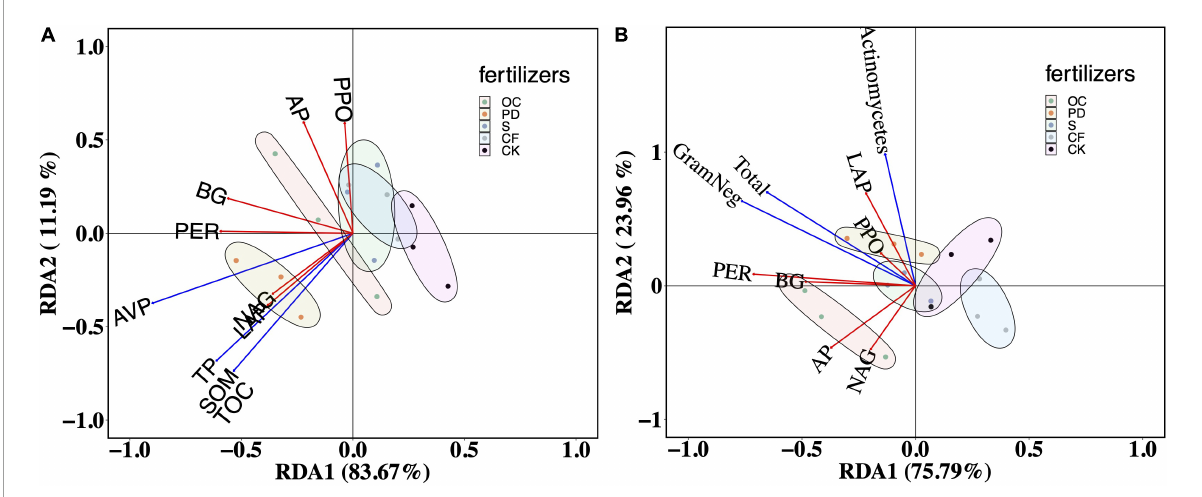
FIGURE4 Redundancy analysis (RDA) of soil organic matter, carbon, phosphorus (A) and the contents of PLFAs (B) on extracellular enzyme activity after 12-year tobacco-maize rotation. SOM, soil organic matter; TOC, total organic carbon; TP, total phosphorus; AVP, available phosphorus; total organisms (Total), total Gram-negative bacteria (GramNeg), total Actinomycetes (Actinomycetes); BG, β -1, 4-glucosidase; NAG, β -1,4-N-acetyl-glucosaminidase; LAP, L-leucine aminopeptidase; AP, acid phosphatase; PER, peroxidase; PPO, polyphenol oxidase. OC, oil cake and inorganic nitrogen; PD, pig dung and inorganic nitrogen; S, straw and inorganic nitrogen; CF, inorganic nitrogen; CK, no